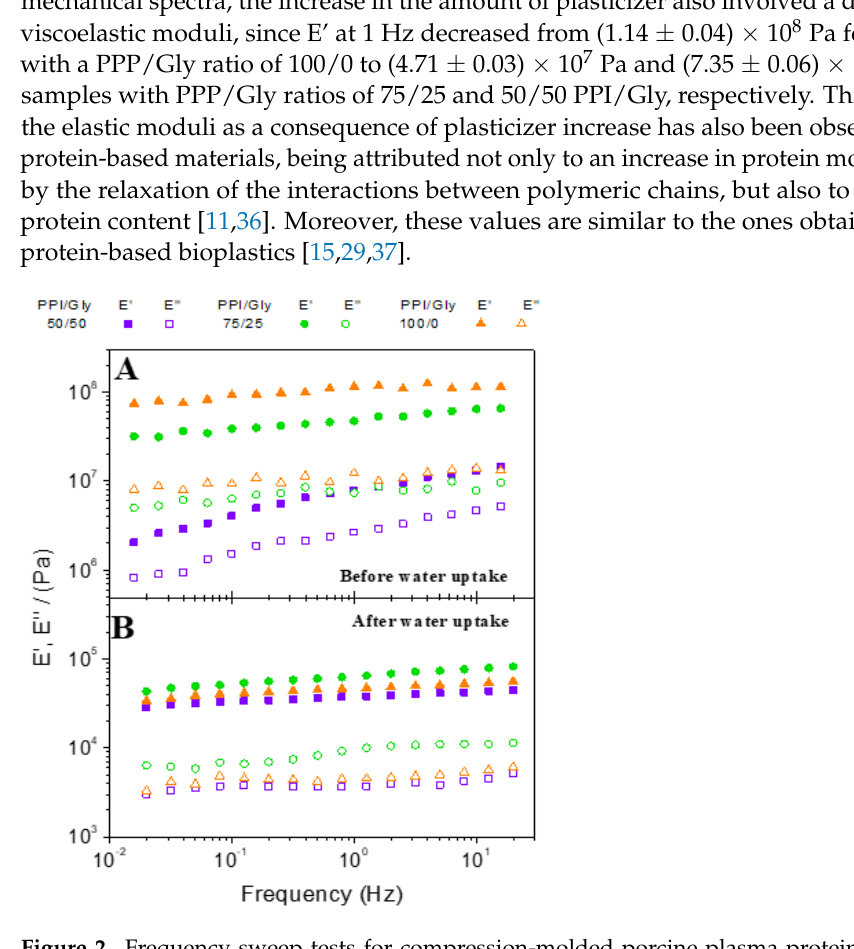
Figure 2. Frequency sweep tests for compression-molded porcine plasma protein (PPP) − based materials plasticized with glycerol (Gly) with different PPP/Gly ratios, 50/50, 75/25, and 100/0, ( A ) before immersion and ( B ) swelled after immersion.